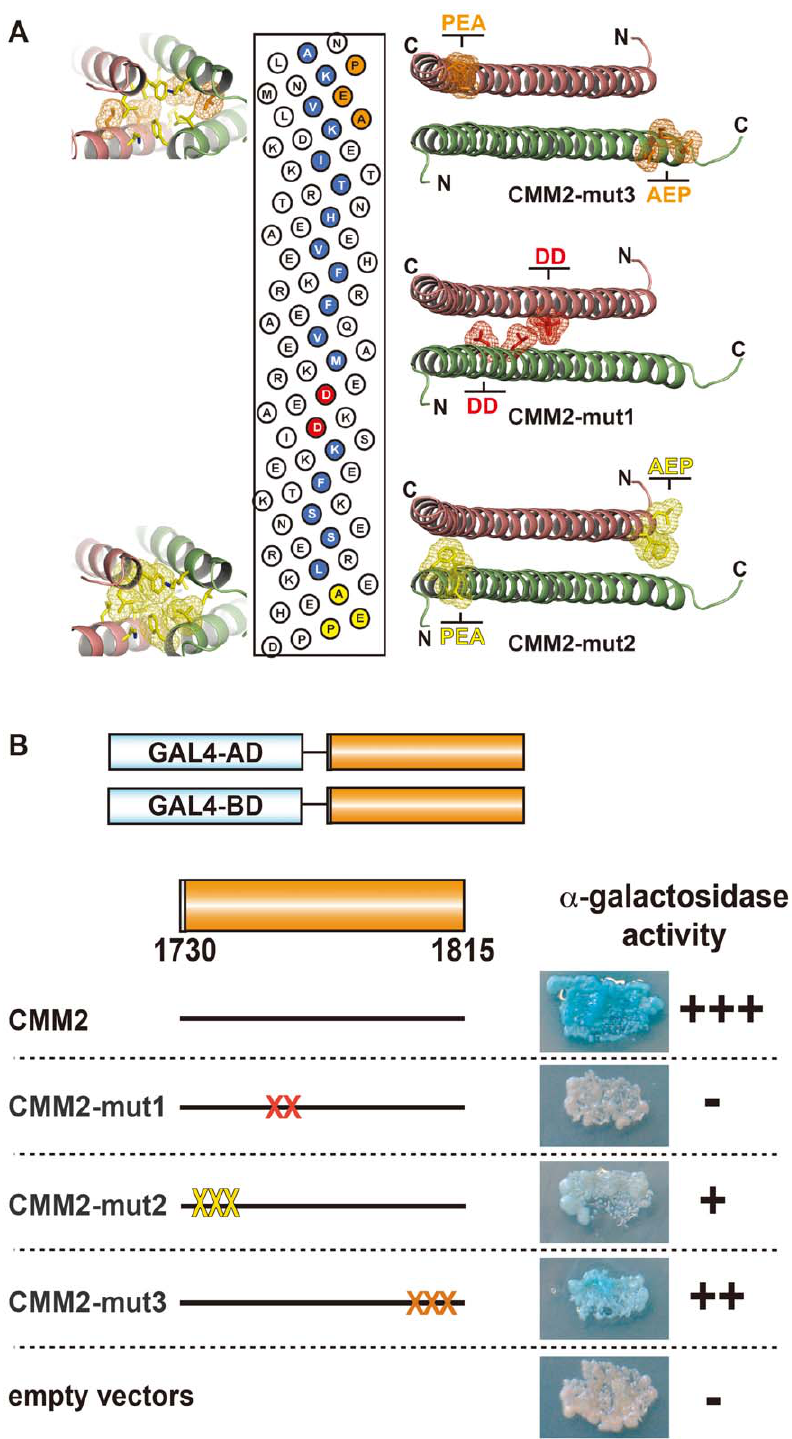
Figure 3. Intermolecular interaction of CMM2 domains invivo. (A) Radial net representation of the CMM2 sequence with the mutated amino acids of the CMM2-mut1, -mut2 and -mut3 constructs indicated in red, yellow and orange, respectively. On each side of the radial net, the CMM2 coiled-coil structure is shown as green- and orange ribbons with the targeted amino acids displayed as sticks surrounded with a mesh surface (colored as described above). (B) Schematic presentation of vectors used in the yeast two-hybrid experiments ( left ) and a -galactosidase staining of yeast co-transformed with corresponding protein fusions (right). ‘‘X’’ on the construct models represents approximate positions of mutations (colored according to A). The ‘‘empty vector’’ contained only GAL4-AD and GAL4-BD.